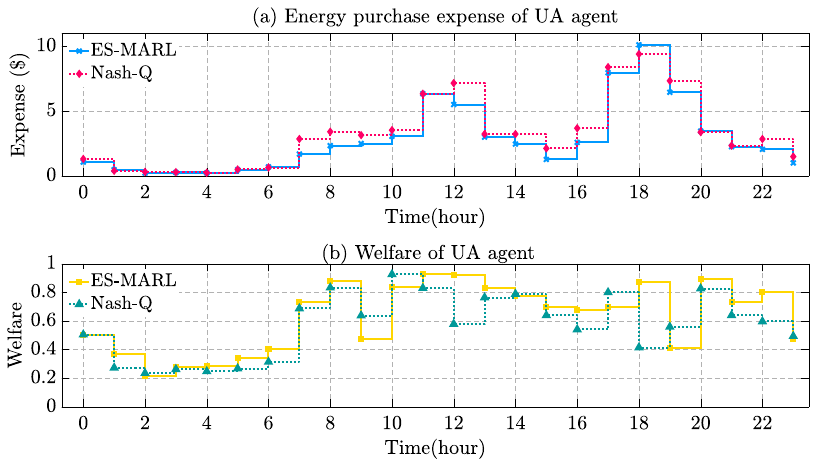
Figure 15. Expense and welfare of UA agent with ES-MARL and